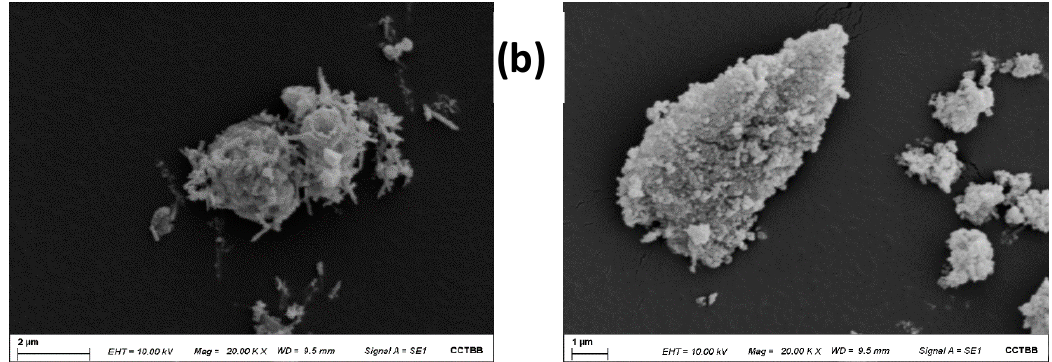
Figure 4. ( a ) SEM image of Mag@Gd(OH) 3 . ( b ) SEM image of a physical mixture of Mag@PEG and Gd(OH) 3 Nps.